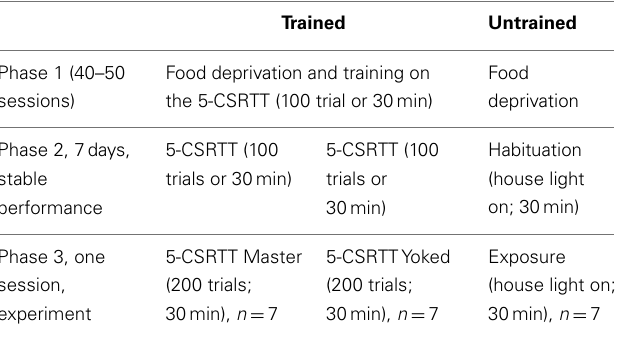
Table 1 | Summary of behavioral procedures.